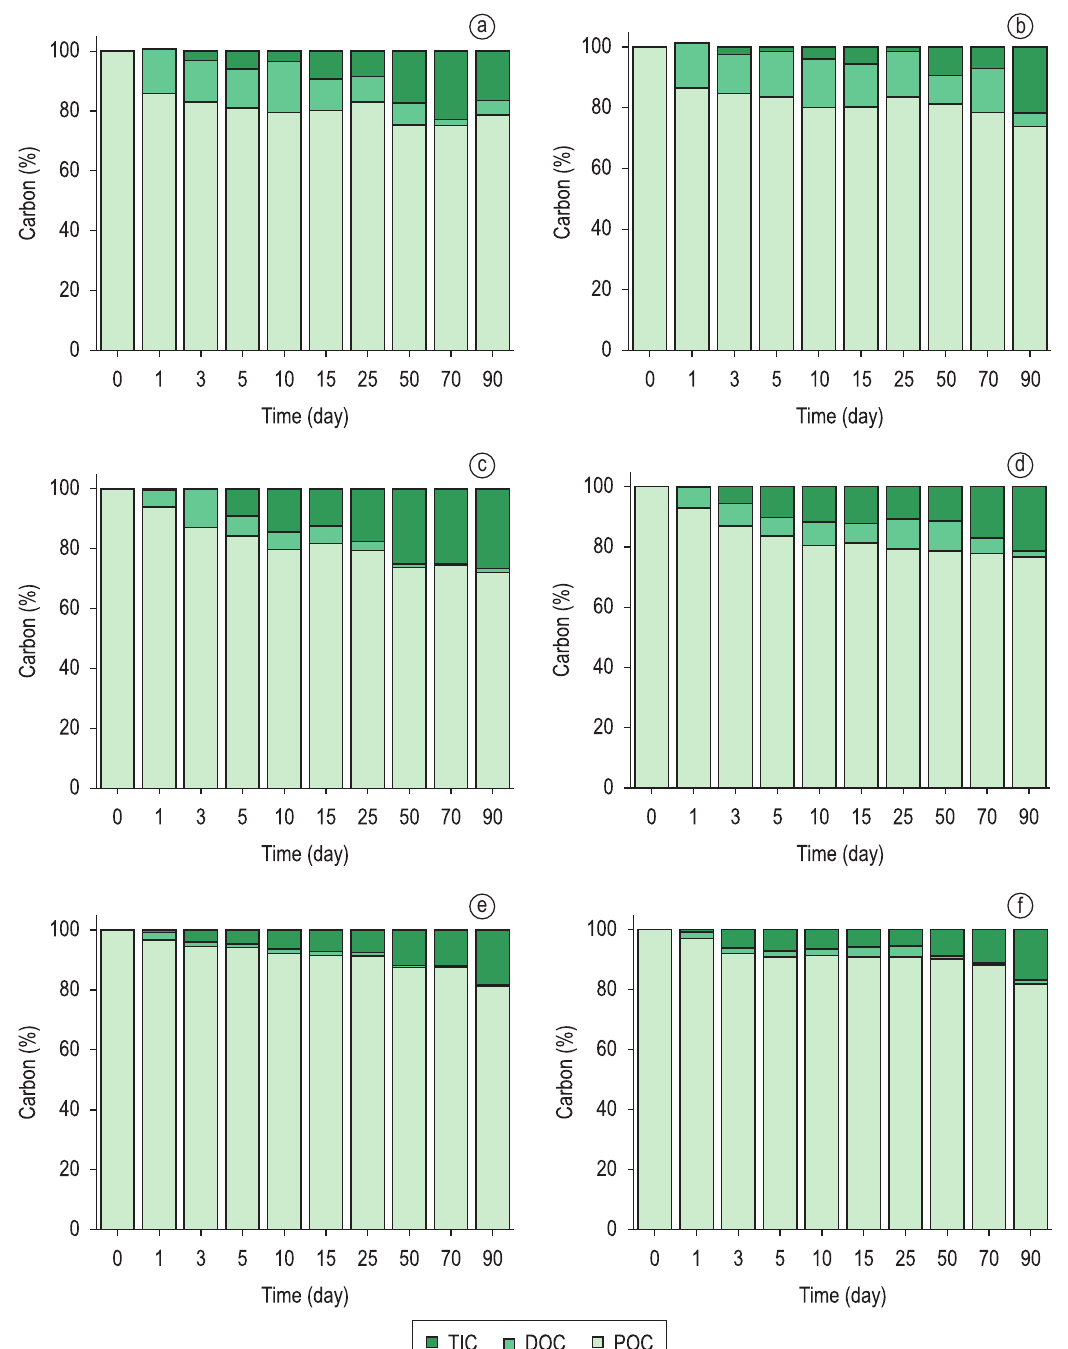
Figure 2. Variations of POC, DOC and TIC during the decomposition of leaves (aerobic (a) and anaerobic (b)), stems (aerobic (c) and anaerobic (d)) and roots (aerobic (e) and anaerobic (f)) of Eichhornia azurea under laboratory